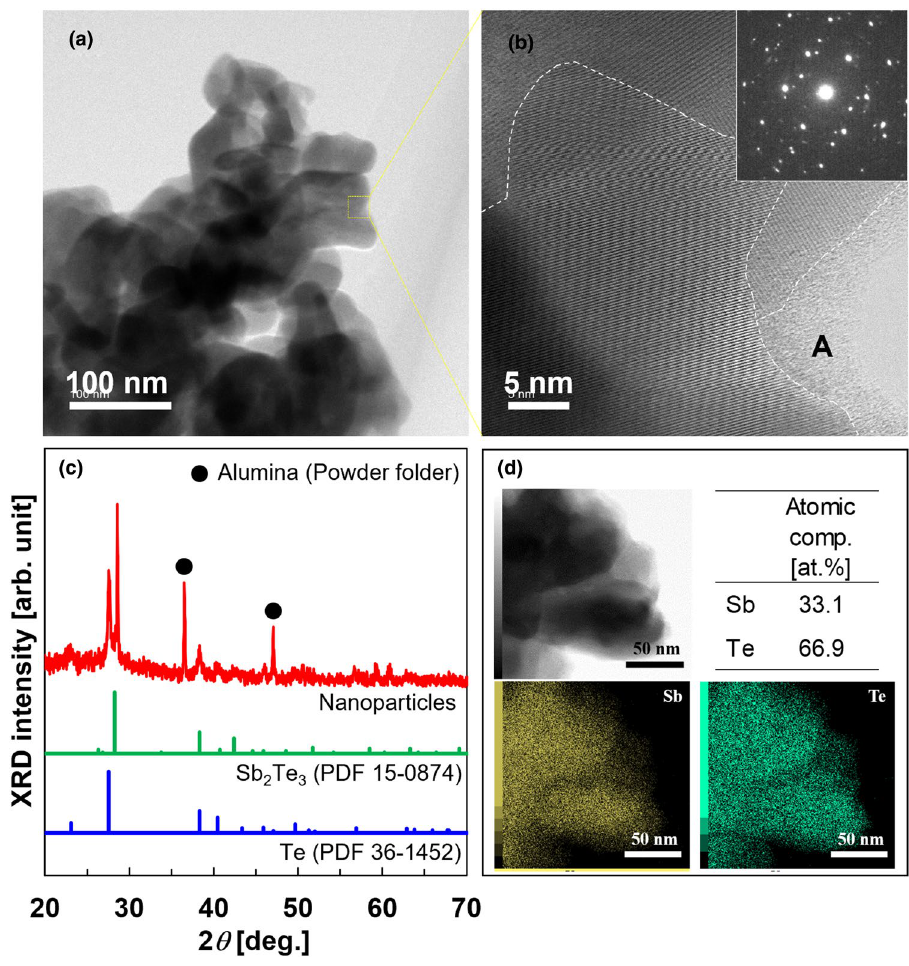
Figure 2. TEM images of Sb 2 Te 3 nanoparticles prepared via spontaneous redox reaction. ( a ) Typical Sb 2 Te 3 nanoparticles, ( b ) corresponding SAED pattern and HR-TEM image of the nanoparticle in ( a ), ( c ) XRD pattern of the nanoparticles, and ( d ) atomic composition and elemental mapping.